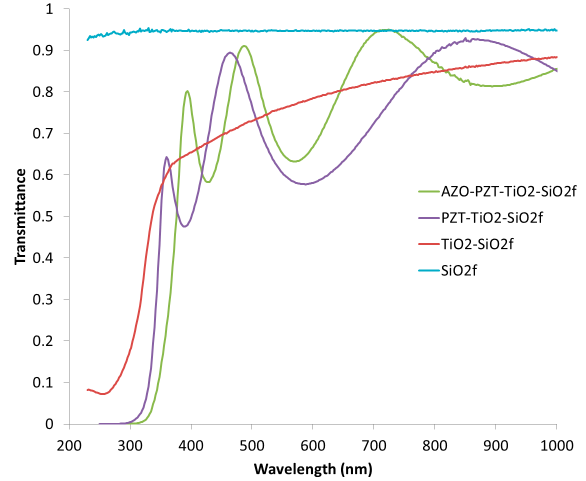
Figure 2. Optical transmission spectra from 232 nm to 1000 nm measured on the successive stacks of AZO/PZT/TiO 2 /fused silica.